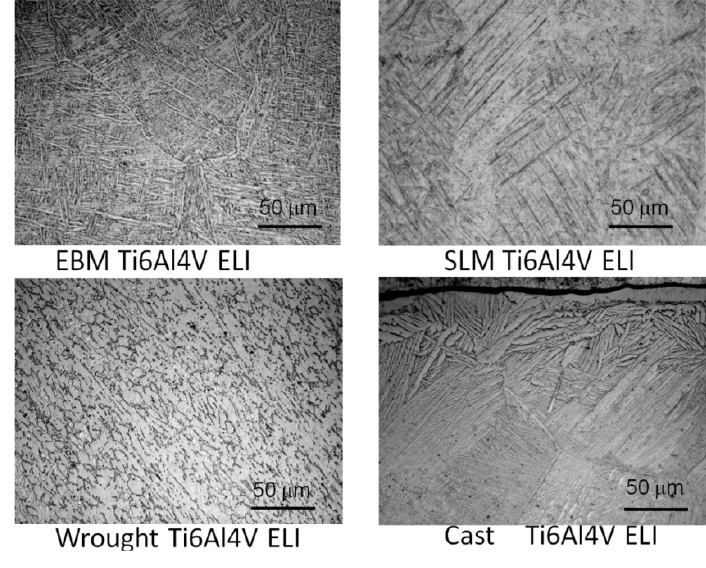
Figure 5. Typical microstructure of ( a ) an LBM specimen; ( b ) an EBM specimen; ( c ) a cast Ti-6Al-4V ELI specimen and ( d ) a wrought